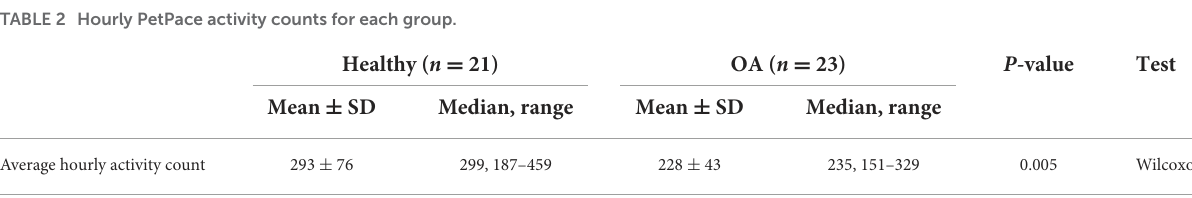
TABLE 2 Hourly PetPace activity counts for each